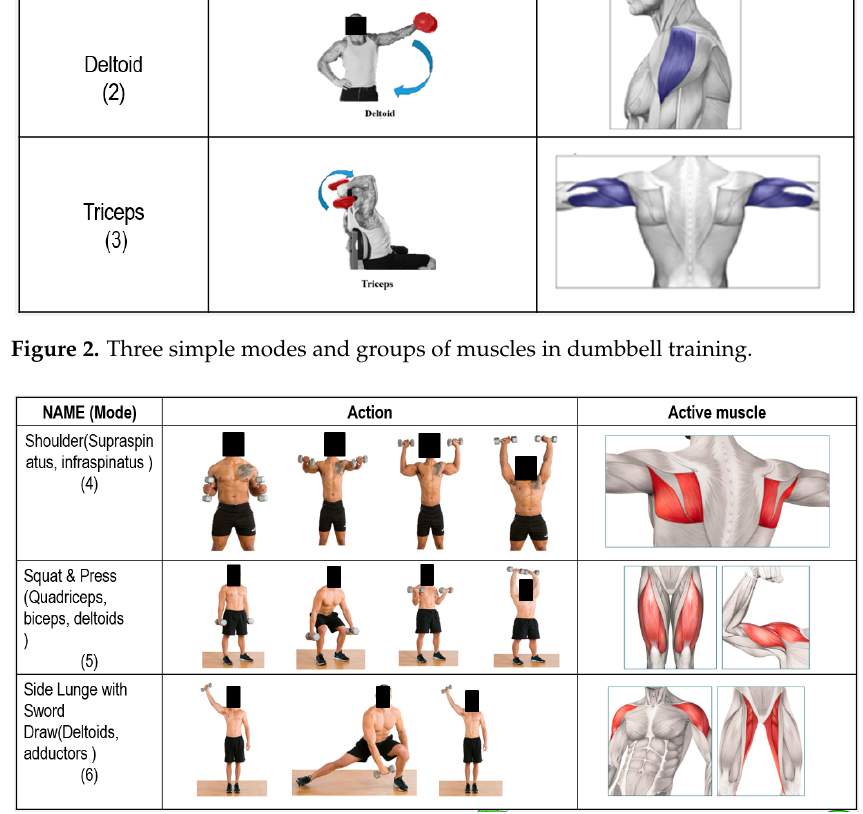
Figure 4. Distribution of angle parameters for six modes (1 = Bicep, 2 = Deltoid, 3 = Tricep, 4 = Shoul- der, 5 = Squat, 6 = Side and lunge). 3. Methodology 3.1. Estimation of Sensor Fusion The raw data from the output of the IMU contain many errors; therefore, we used the Kalman filter to reduce the noise. It includes two steps to process the data, i.e., prediction and update [22–24]. The equations of the algorithm are summarized as follows: Prediction : Predicted state estimate